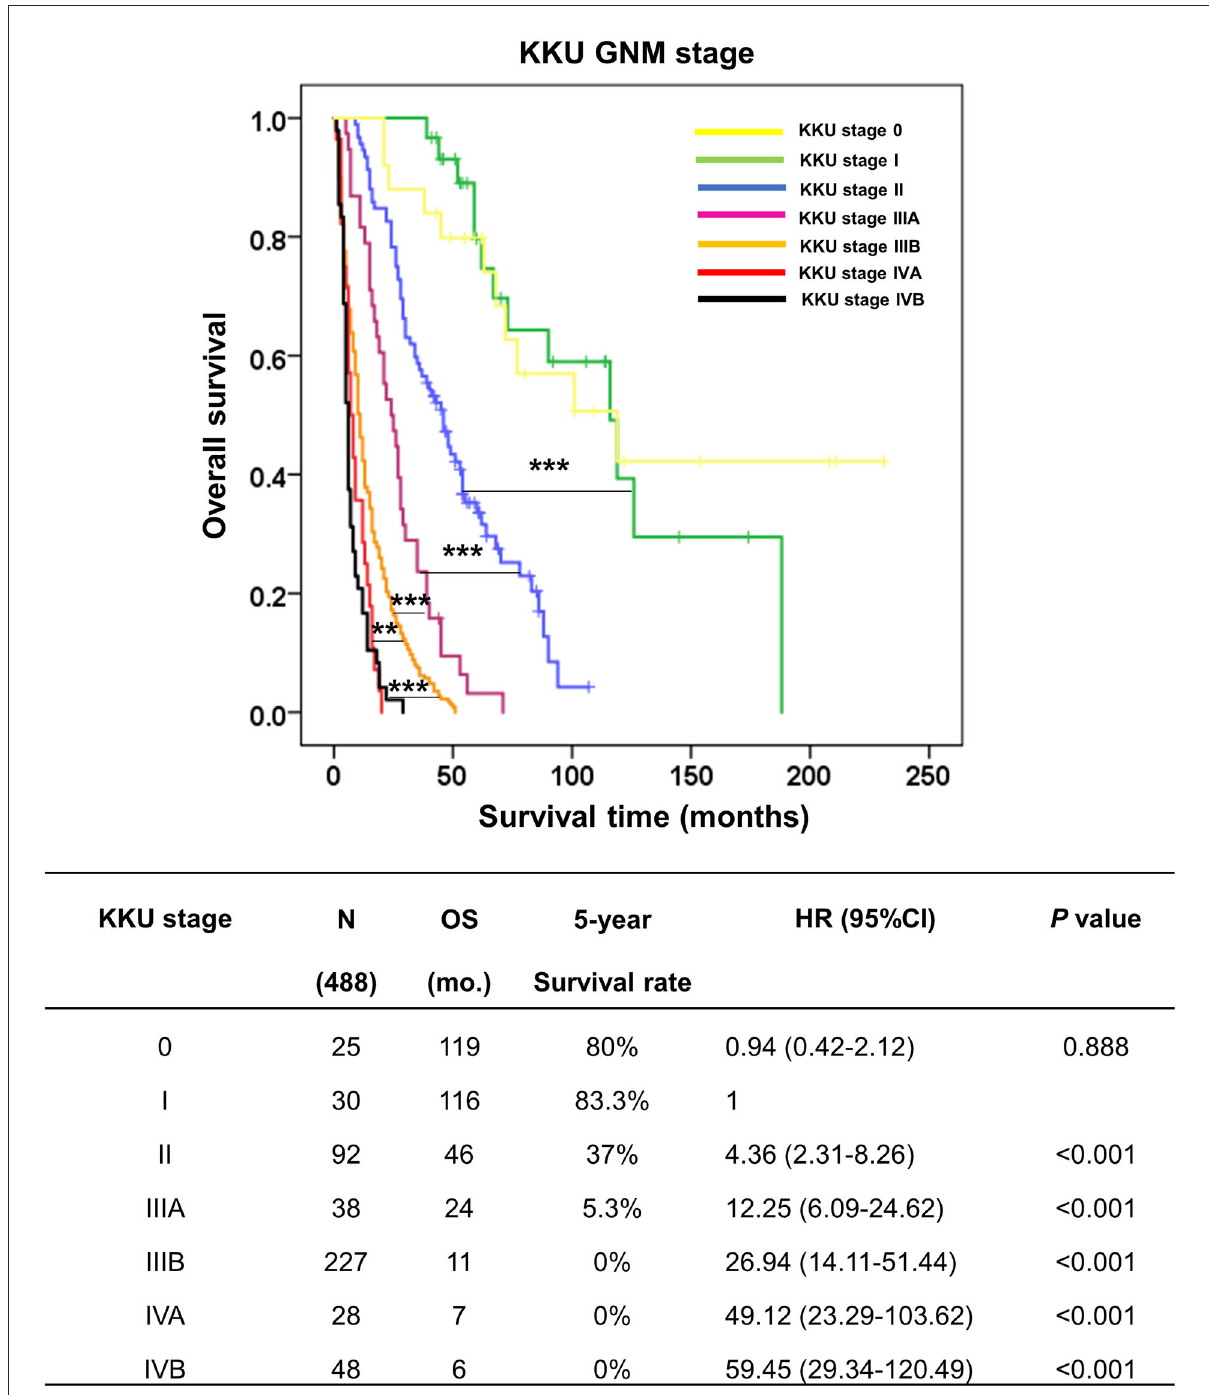
FIGURE7 Kaplan–Meier curve represented the overall survival of perihilar cholangiocarcinoma patients with GNM stages by the KKU staging system. The table represented the outcomes of patients with GNM stage by the KKU staging system, namely, KKU stage, number of cases, overall survival, 5-year survival rate, hazard ratio, and p-value. ** p < 0.01 and *** p < 0.001.